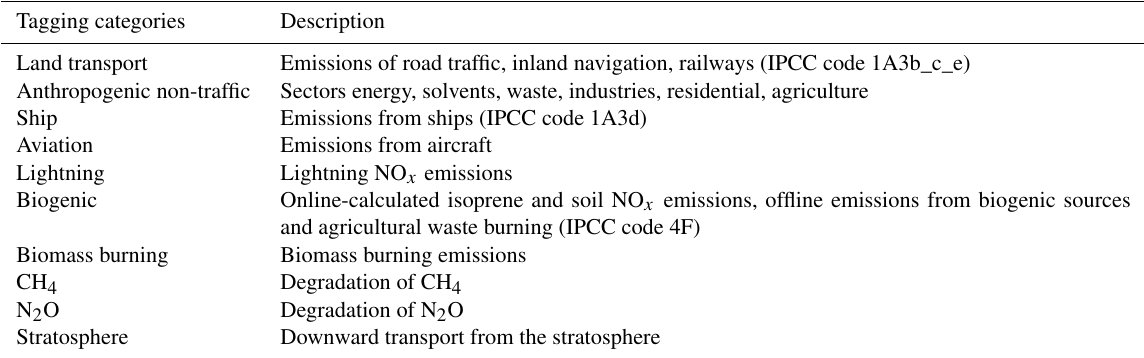
Table 1. Description of the different categories as used by the TAGGING submodel. Tagging